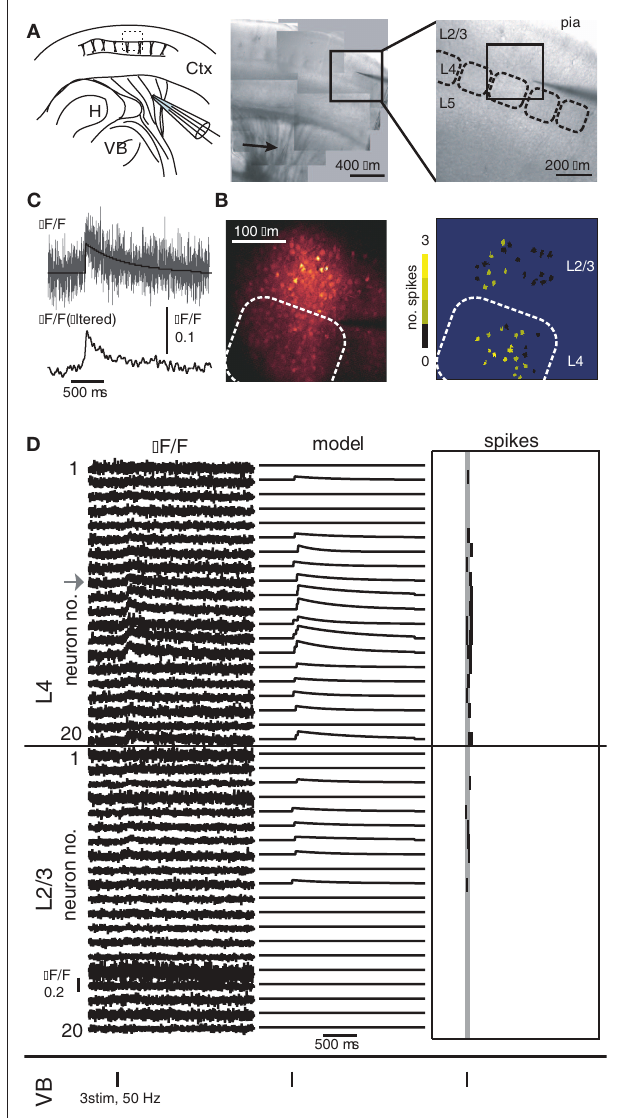
Figure 1 | Propagation of spiking activity from L4 to L2/3. (A) Left: Illustration of experimental design. H, hippocampus; VB, ventrobasal nucleus of the thalamus; Ctx, cerebral cortex. Center image shows patchwork of photomicrographs showing striatum and barrel cortex in an acute thalamocortical slice. Arrow indicates position of stimulation pipette. Right image shows photomicrograph of the barrel cortex; dashed boxes illustrate L4 barrels. Image shows region indicated by box in center image. The dark shadow visible on the right is a pipette that was positioned at the border between L4 and L2/3 as a marker. (B) Left image shows fluorescence image of the region indicated by box in right image in (A) . Rounded box illustrates barrel borders. Right image illustrates locations of recoded neurons, with their activity in one trial encoded in pseudocolors. (C) Magnification of fluorescence trace of one neuron for illustration. Bottom trace shows fluorescence signal (above) filtered with a 30-ms Hamming filter. (D) Suprathreshold activity recorded from 40 neurons using dithered random-access scanning, 20 neurons in L4 and 20 neurons in L2/3. Left traces show fluorescence signals (arrow marks the example neuron in C ), center traces show model with maximum-likelihood, right traces detected spike timings. Gray line indicates the time window of the fiber stimulus provided. Stimulus timings are also illustrated by vertical bars below each set